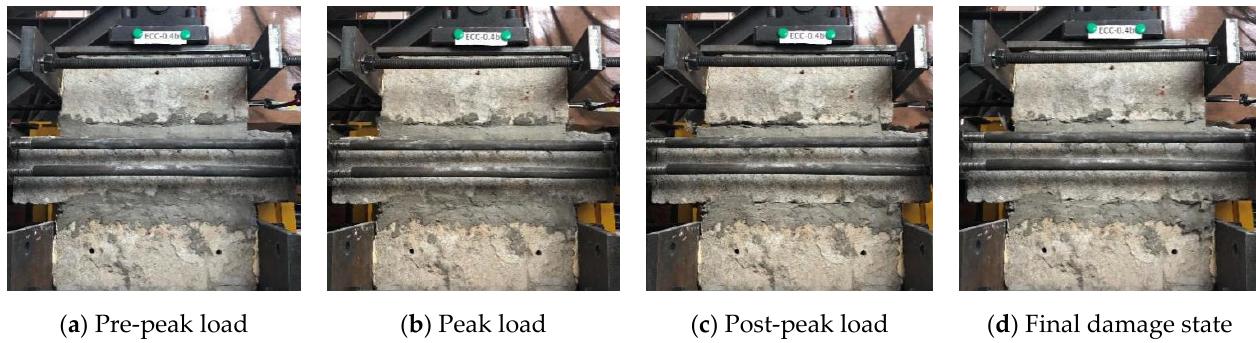
Figure 11. Typical failure process of ECC specimens (ECC-0.4): ( a ) Pre-peak load, ( b ) Peak load, ( c ) Post-peak load and ( d ) Final damage state.